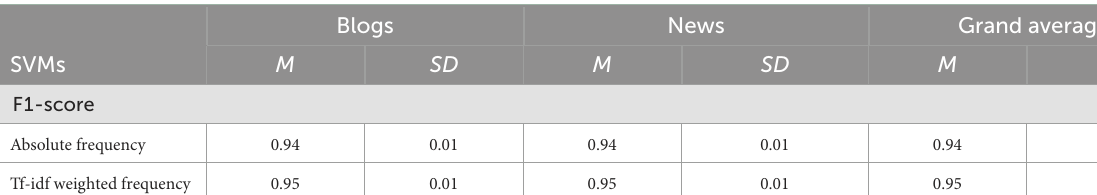
TABLE 6 A comparison of the classification performance of the fitted SVMs.